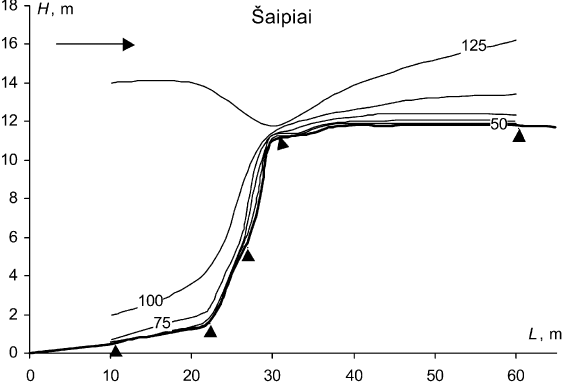
Fig. 4. Variations in wind speed (%) in the cross-shore profile near